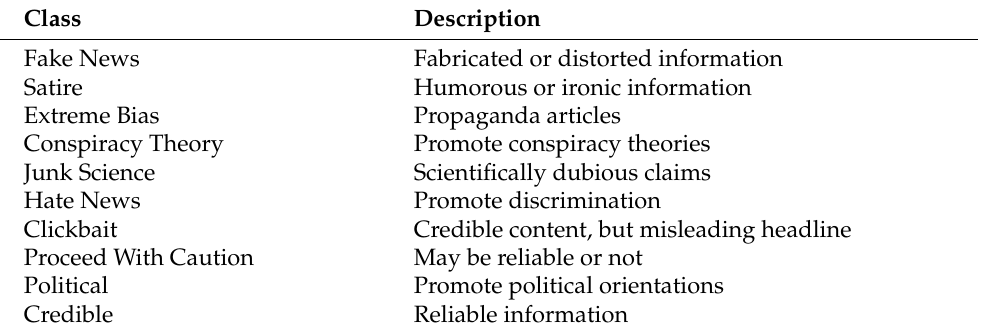
Table 1. News article classes.